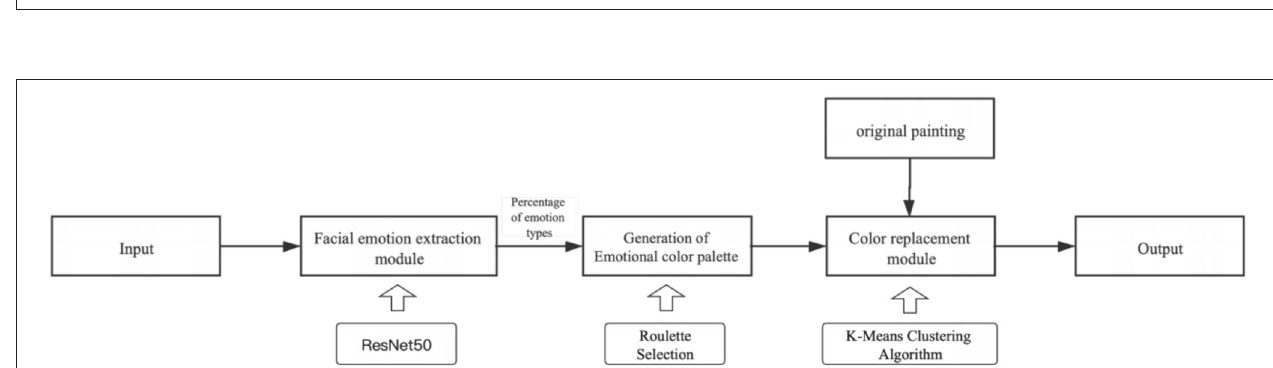
FIGURE 6 | The user operation flow chart.